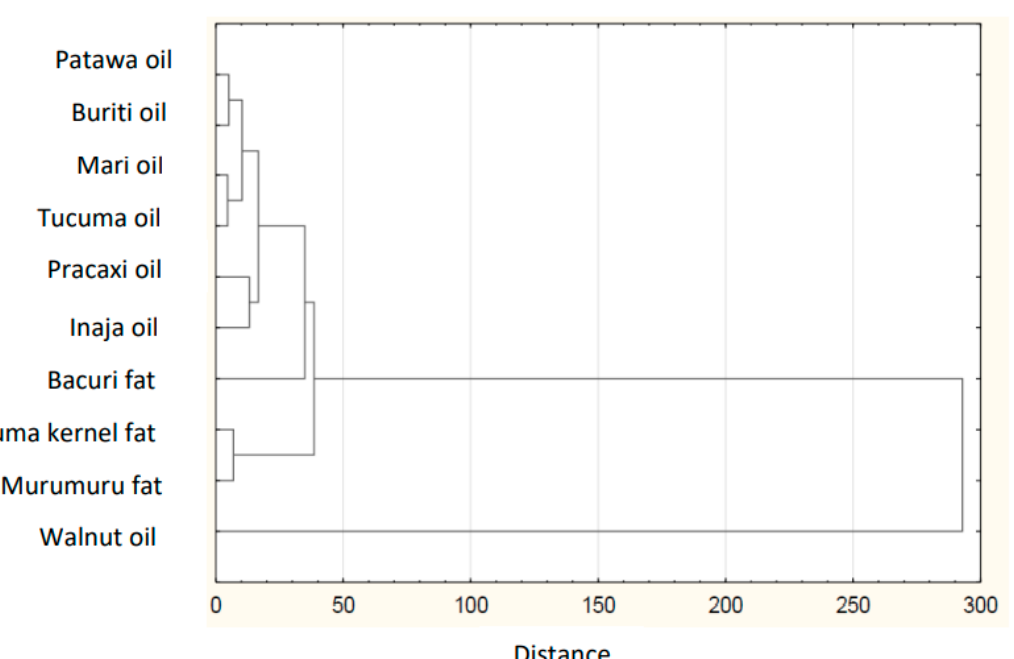
Figure 3. Hierarchical cluster graph of nut oils.